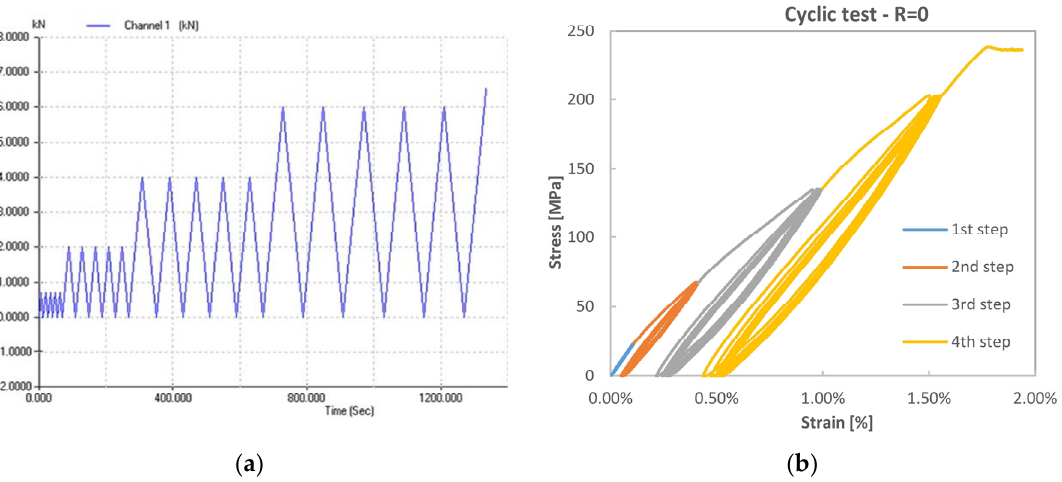
Figure 7. Tensile test with embedded load ‐ unload R = 0 cycles for a VB sample. ( a ) Definition of load ‐ controlled cycling history; ( b ) Stress ‐ strain plot.